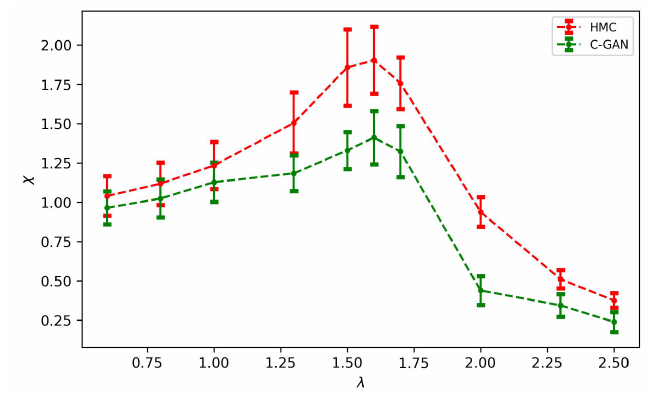
Figure 21: Ablation for periodic padding: Susceptibility on Λ padding in both generator and